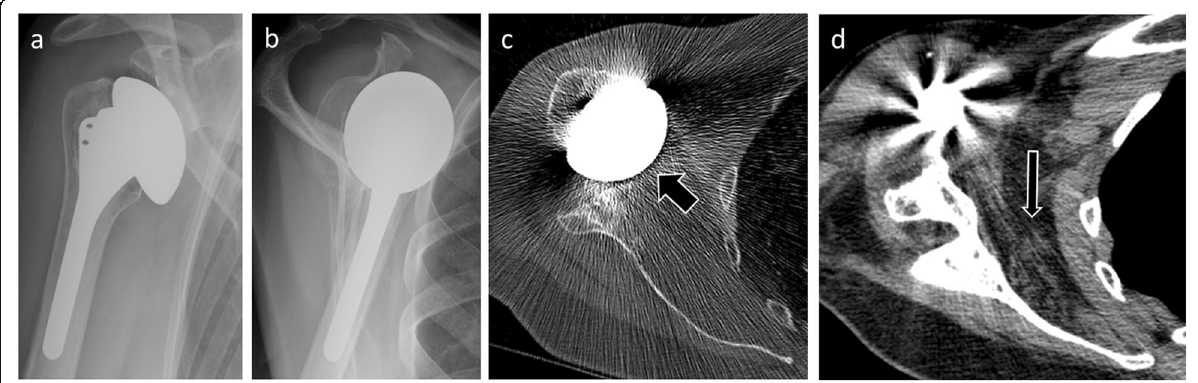
Fig. 20 Anteroposterior ( a ) and scapular Y ( b ) radiographs in a 52-year-old woman with total shoulder arthroplasty and anterior instability show an anterior translation of the humeral head. c Axial CT image confirms this anterior translation (thick arrow). d Axial CT image with smooth reconstruction filter shows fatty degeneration of the subscapularis muscle (thin arrow). All these elements lead to suspicion of subscapularis tendon tear and this tear was confirmed during